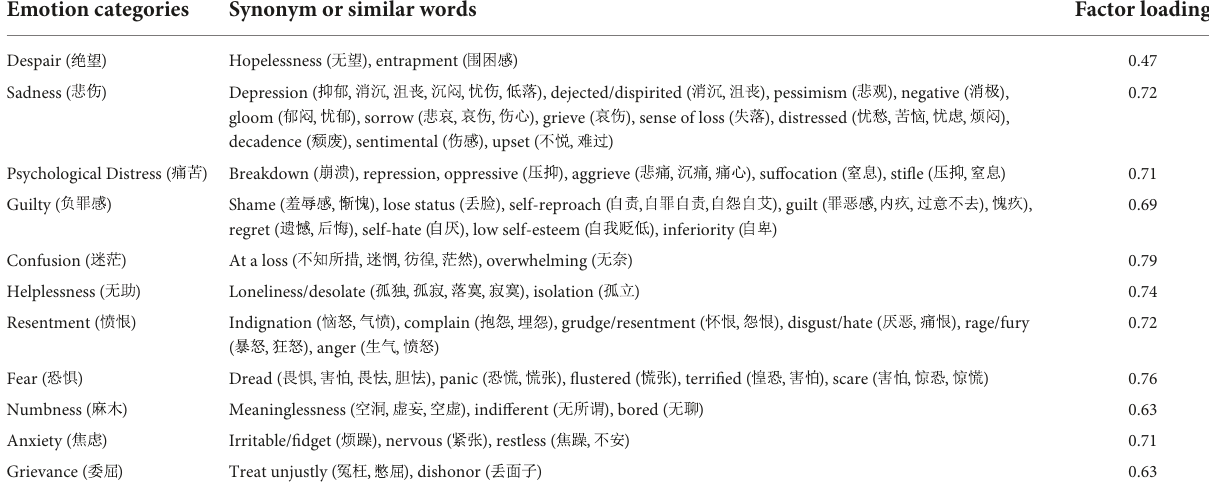
TABLE 2 Details of the EWLSRA and loadings of 11 suicide-related emotional words in the one-factor model among 201 respondents. Emotion